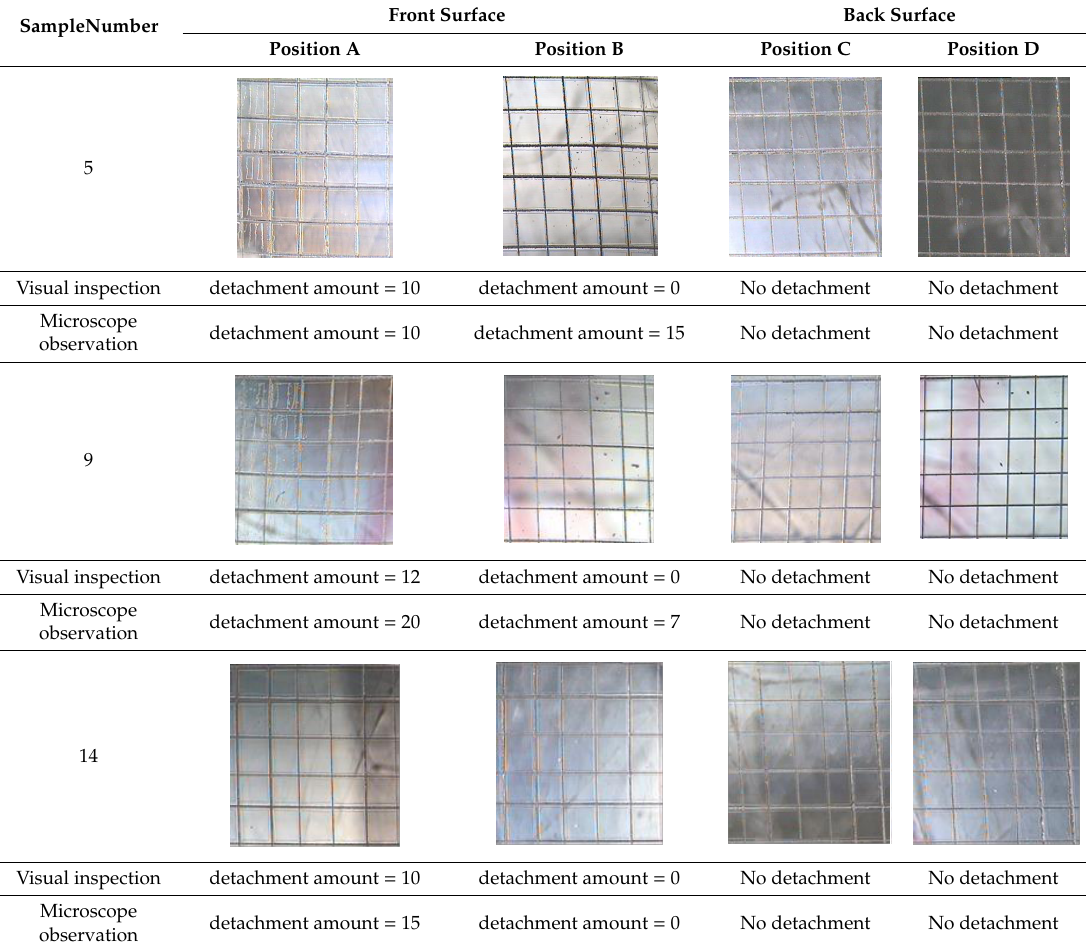
Table 5. Microscope images of No. 5, 9, and 14 lenses.